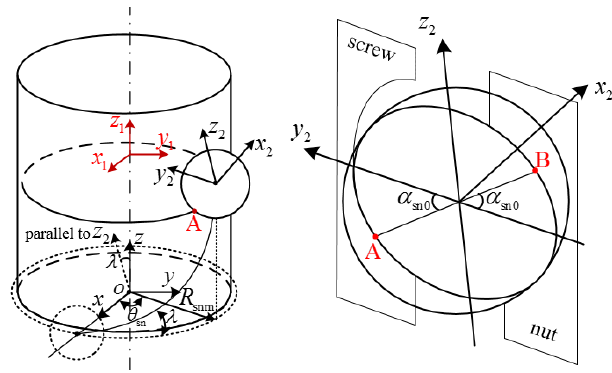
Figure 2. The relationship between different coordinate systems.